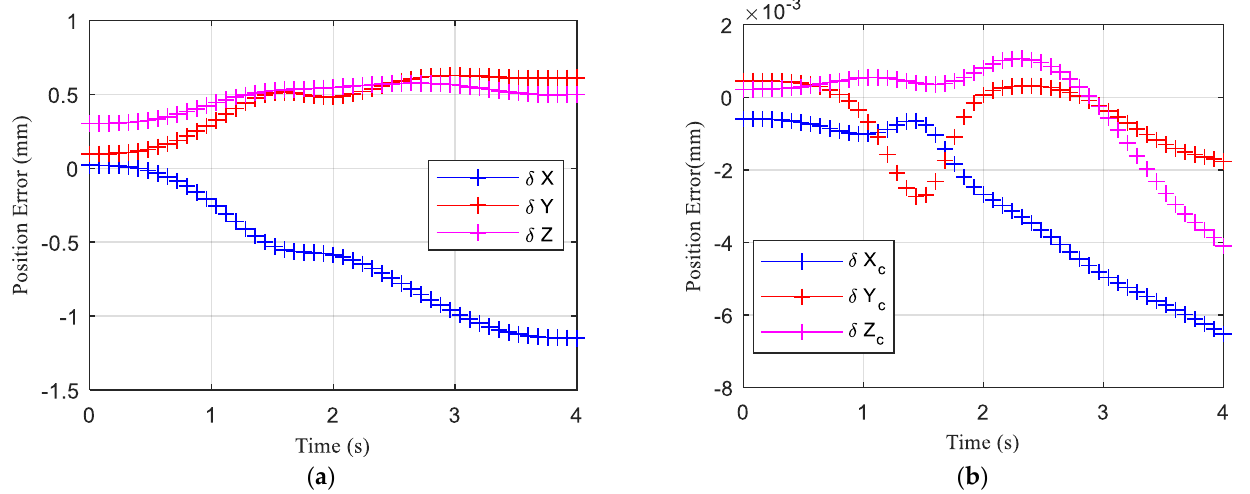
Figure 13. The real-time position error of the humanoid manipulator in motion. ( a ) No trajectory compensation; ( b ) With trajectory compensation.